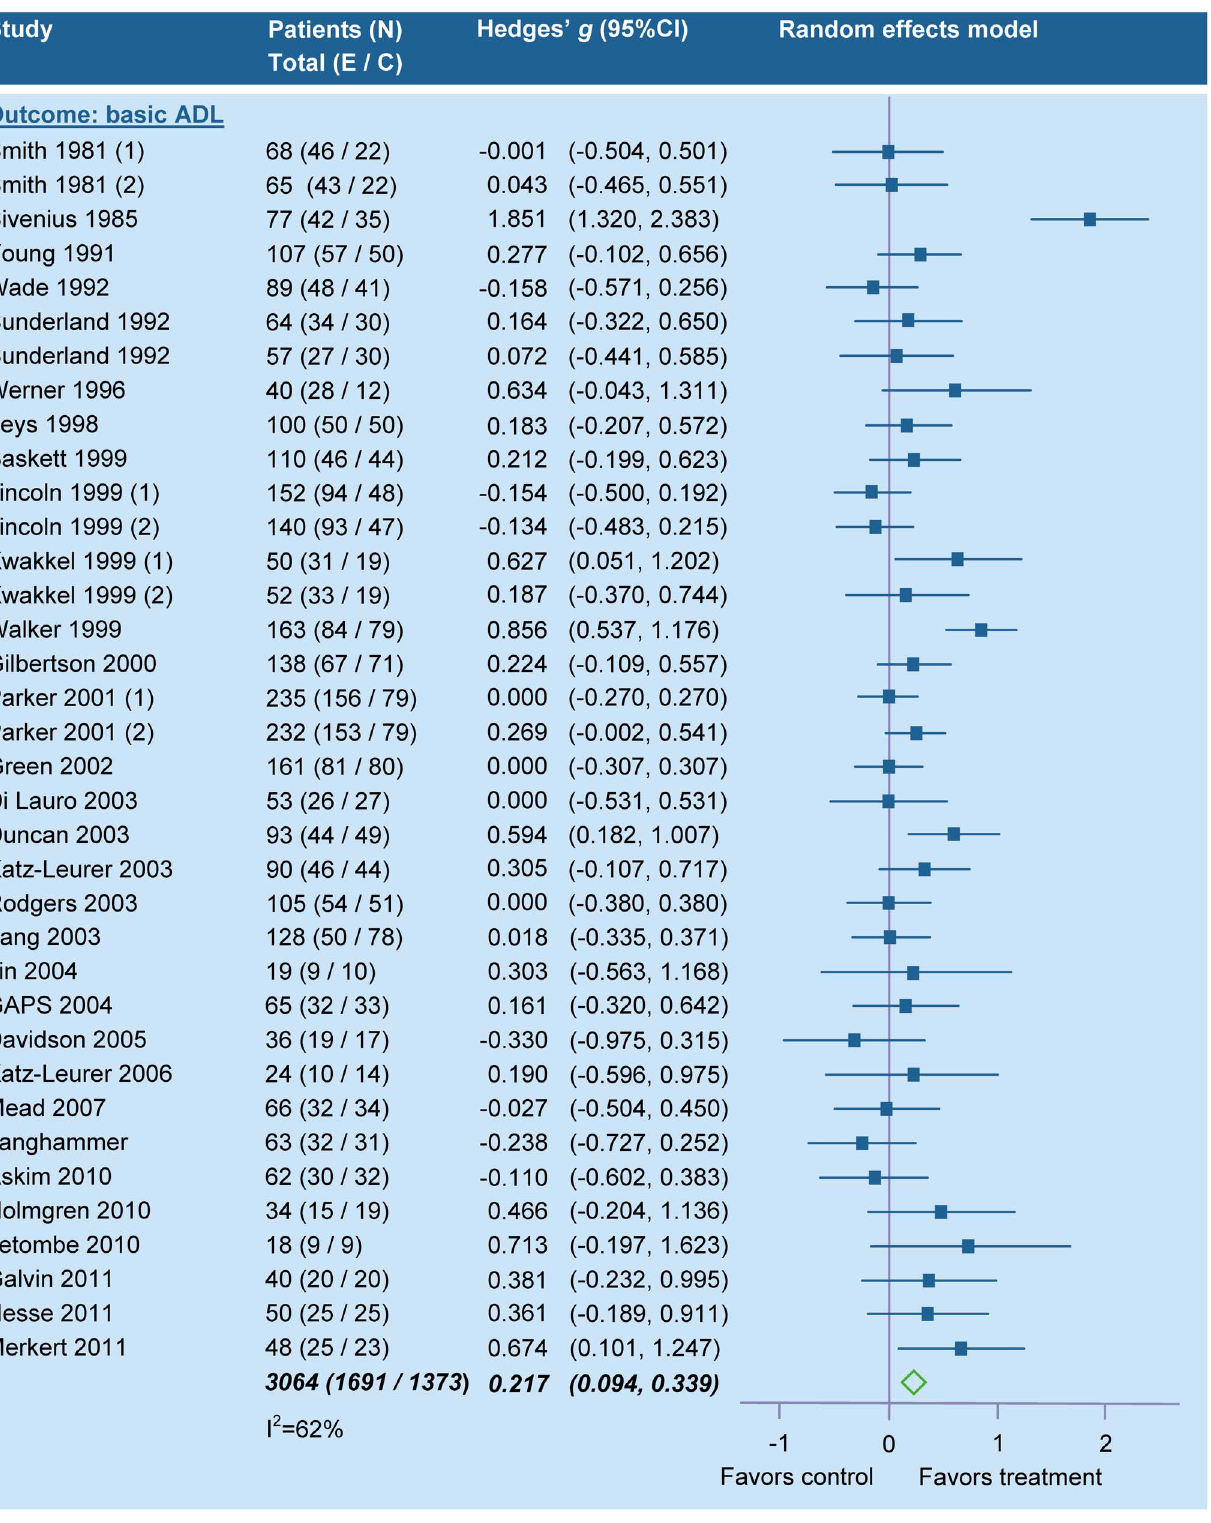
Figure 7. Summary effect sizes for physical therapy interventions – intensity of practice. Legend: ADL, Activities of daily living; C, Control group; CI, Confidence interval; E, Experimental group.